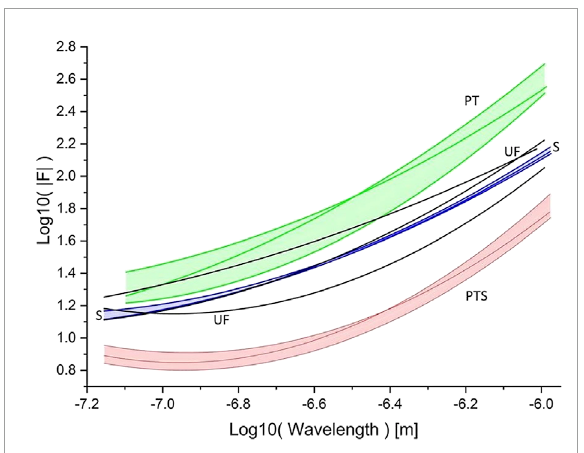
FIGURE 11 Spectra of three longitudinal lines along a single cuticle. FFT for untreated fabric (UF, black lines), sprayed (S, blue lines and band), plasma-treated-only (PT, green lines and band), and plasma-treated and sprayed (PTS, red line and band). The lines (S, PT, and PTS) have been smoothed with a third-order polynomial. The corresponding one standard deviation bands are shown to ease the comparison between the different samples.